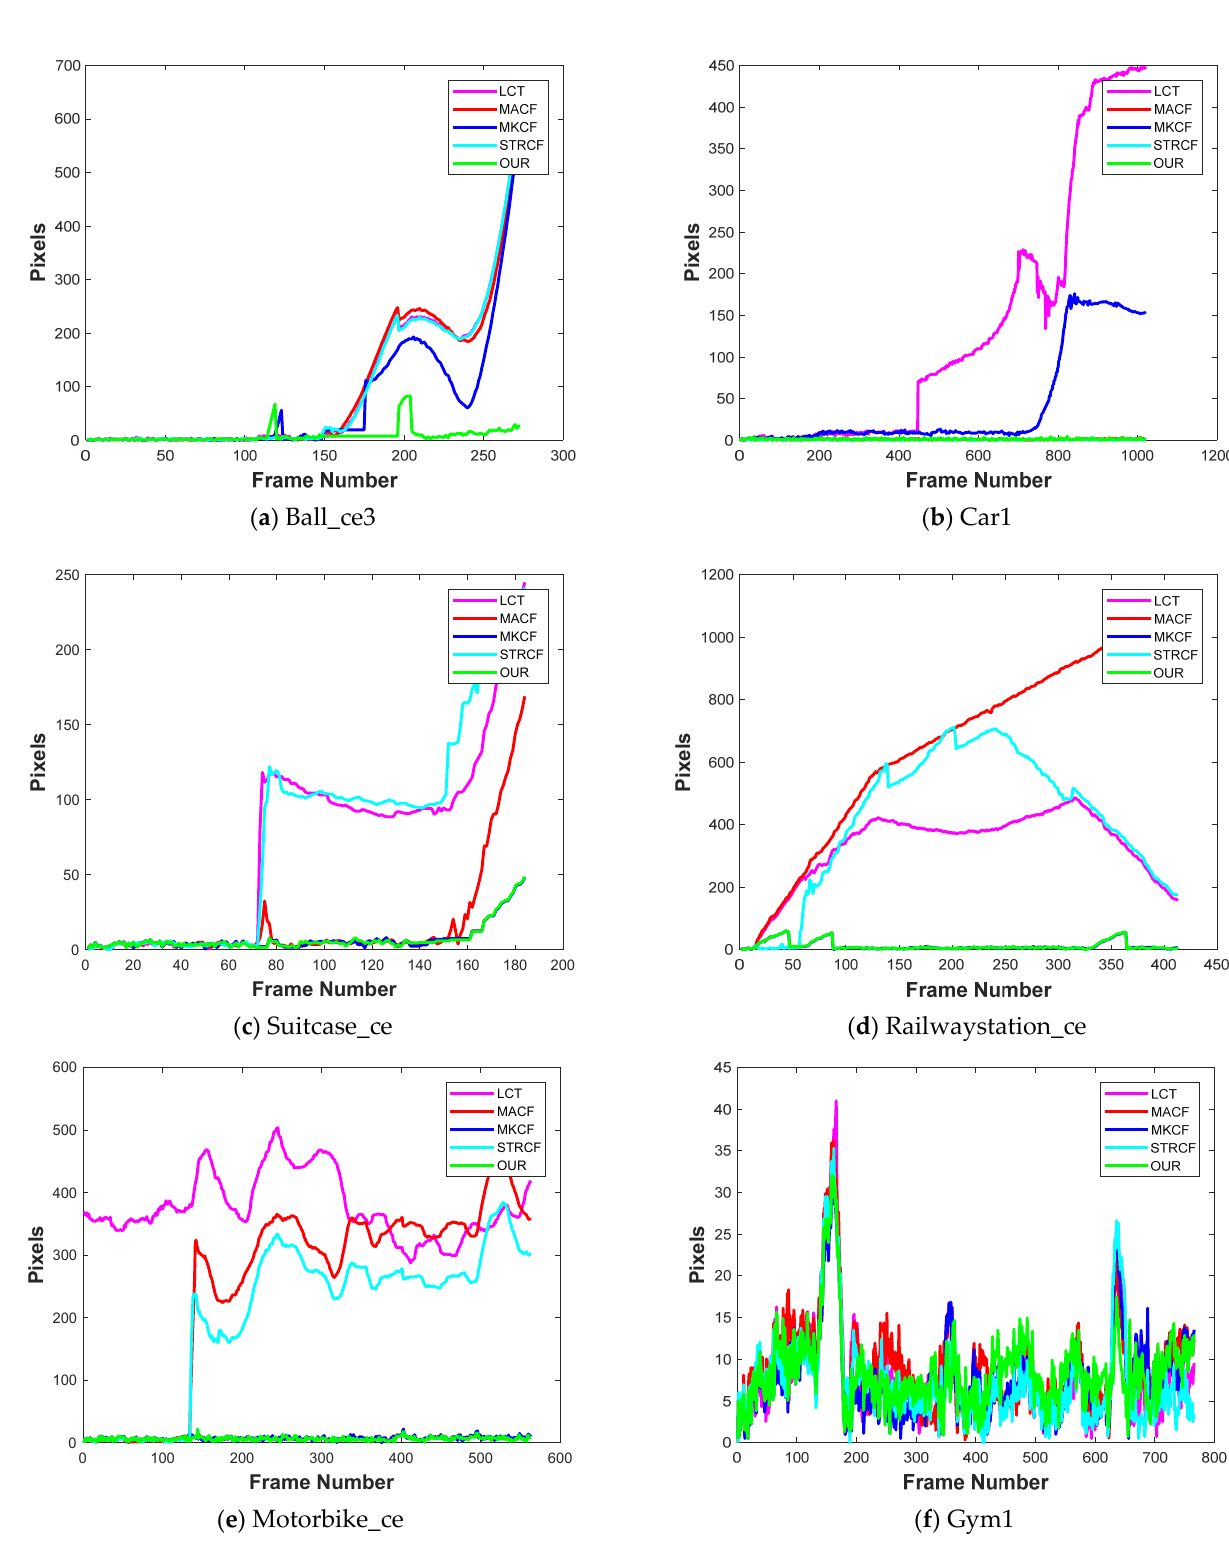
Figure 4. Quantitative analysis: comparison based on center location error. Six videos are selected from OTB-50, OTB-100, and Colour-128 datasets.